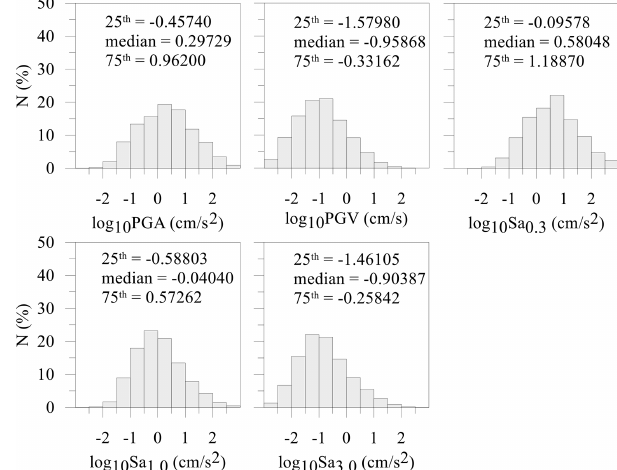
Figure 3. Distribution of output data for the training dataset in terms of geoH